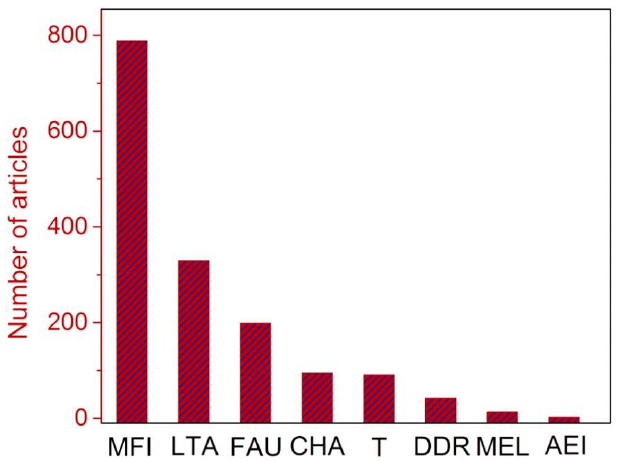
Figure 6. Number of publications for different zeolite topologies in Scopus. (zeolite T is an ERI-OFF intergrowth-type zeolite; MFI contains ZSM-5 and Silicate-1; CHA contains chabazite, CHA and SAPO-34 etc.). Figure modified with permission of the authors of [103].